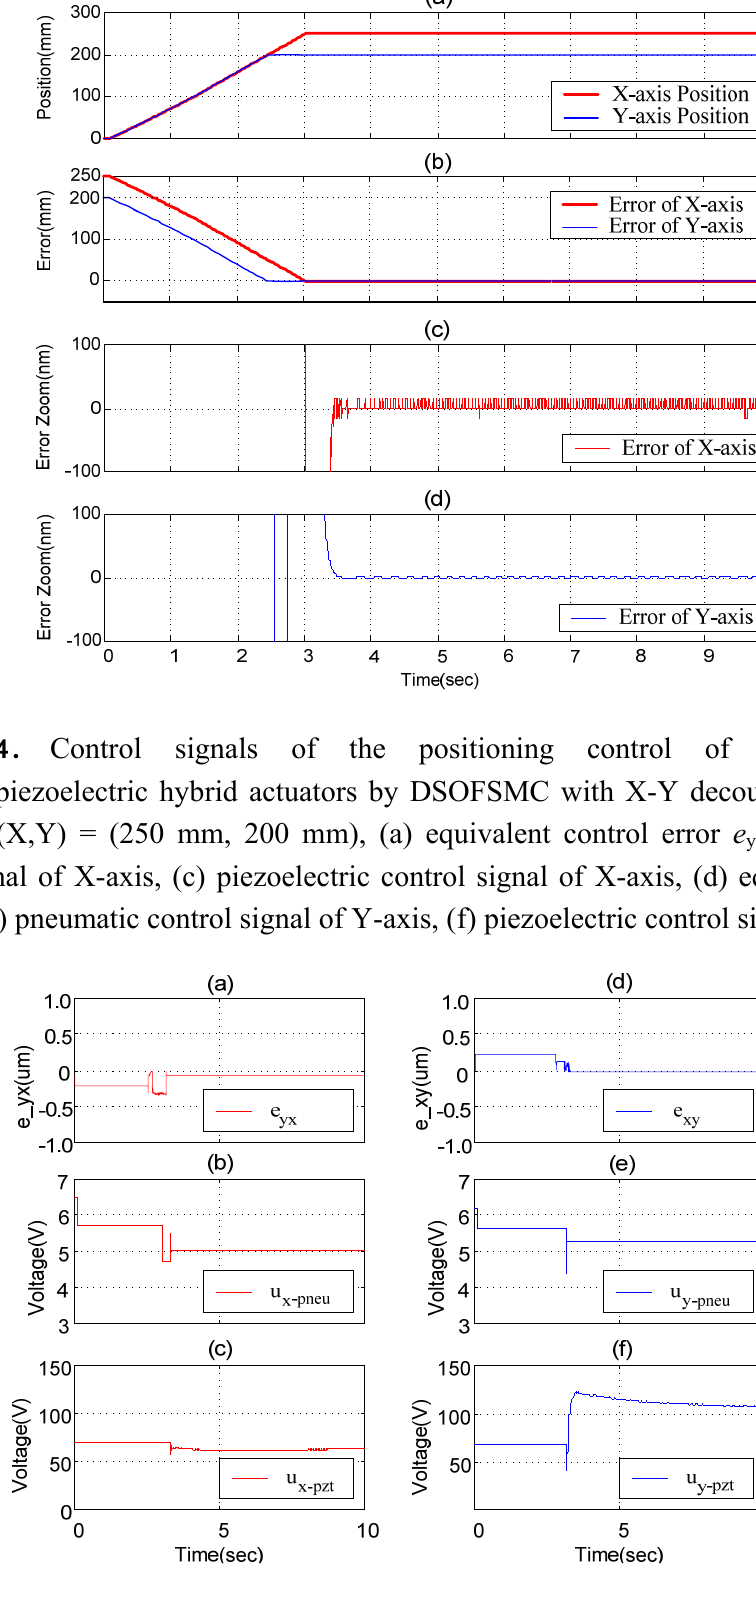
Figure 13. Experimental results of the positioning control of XY dual-axial pneumatic- piezoelectric hybrid actuators by DSOFSMC with X-Y decoupling controller: strokes of (X,Y)= (250 mm, 200 mm), (a) position control response of X- and Y-axes. (b) error of X- and Y-axis. (c) error zoom of X-axis. (d) error zoom of Y-axis.